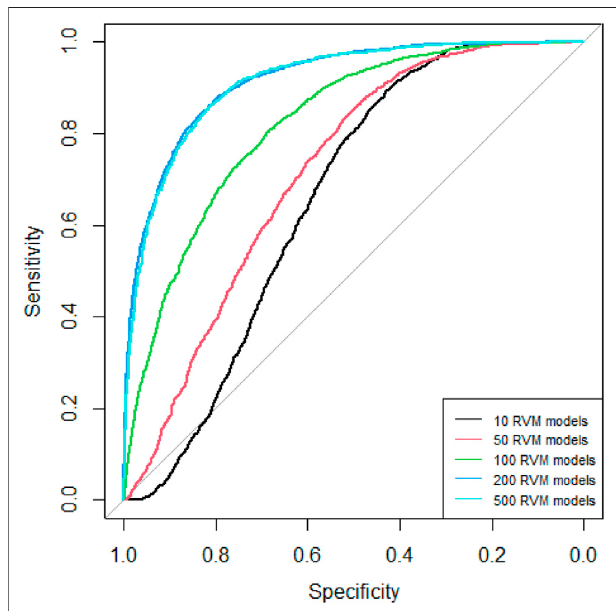
FIGURE 2 | ROC curves of different RVM